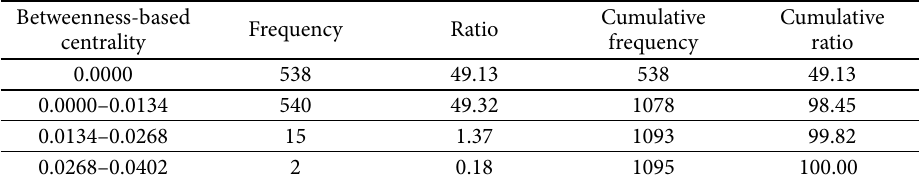
Cumulative Cumulative frequency